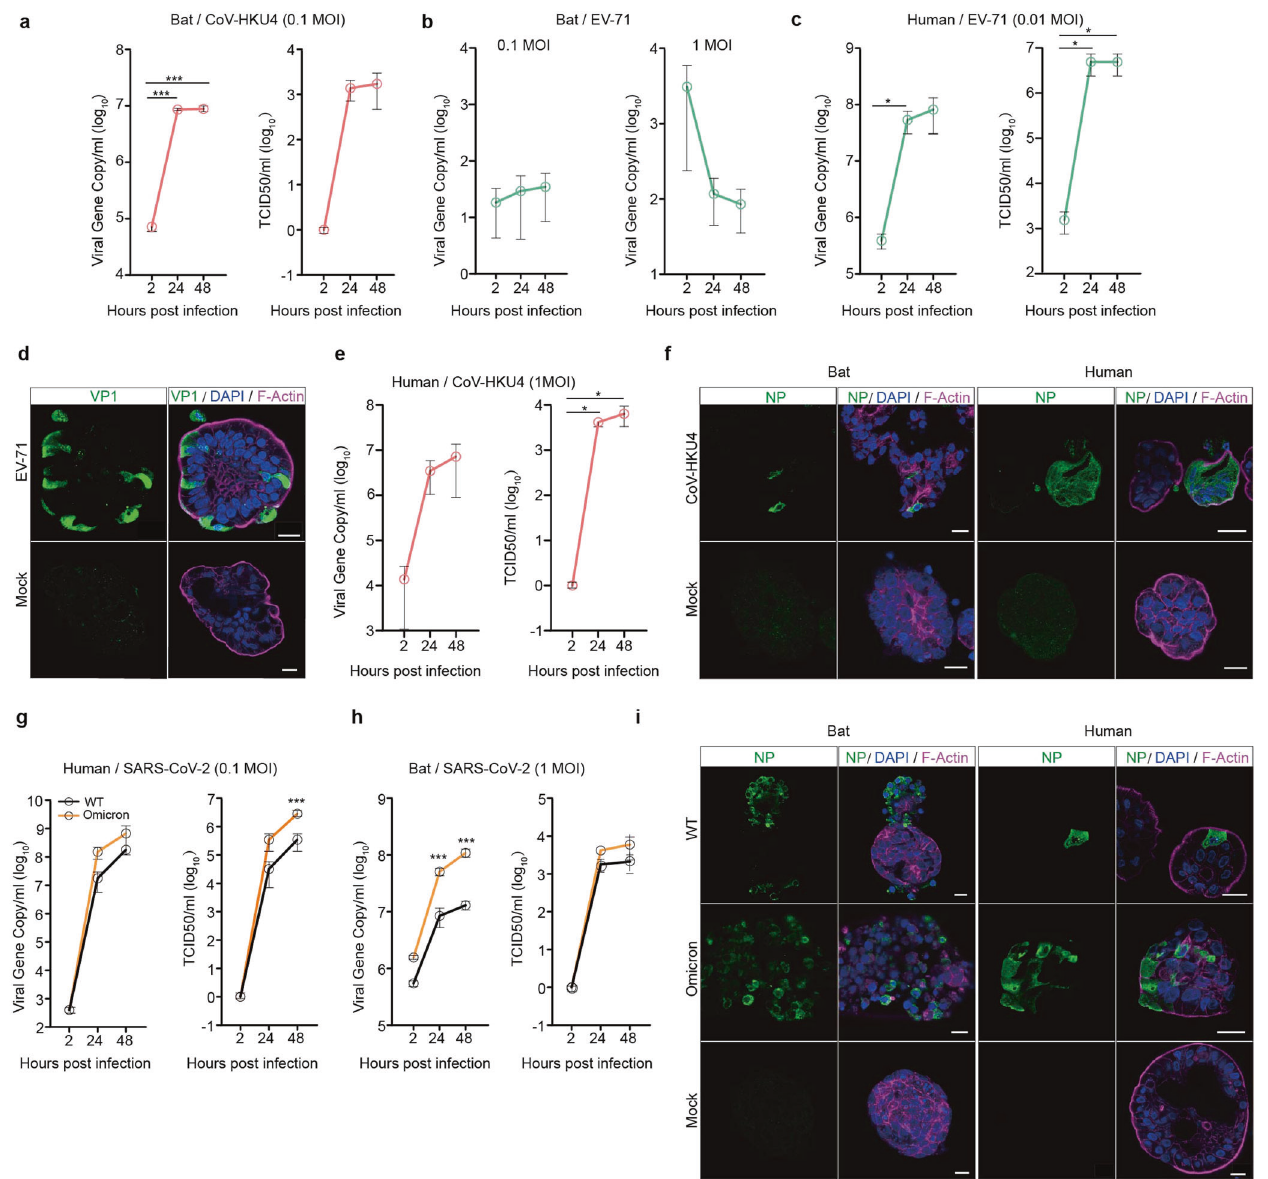
Fig. 4 Bat intestinal organoids reproduced bat susceptibility to coronaviruses. a – c At the indicated hours after bat intestinal organoids inoculated with CoV-HKU4 ( a ), EV-71 ( b ) and human intestinal organoids inoculated with EV-71 ( c ), culture media were harvested and applied viral protein VP1 positive (green) cells. Nuclei and actin fi laments were counterstained with DAPI (blue) and Phalloidin-647 (purple), respectively. Scale bar, 20 µm. e At the indicated hours after human intestinal organoids inoculated with CoV-HKU4, culture media were harvested and applied to viral load detection and viral titration. Data represent mean and s.d. in a representative experiment, n = 3. Two-tailed unpaired Student ’ s t test. f Bat and human intestinal organoids infected with CoV-HKU4 or mock-infected were fi xed and immunostained to identify CoV-HKU4 NP positive (green) cells. Scale bar, 20 µm. g , h At the indicated hours after human and bat intestinal organoids inoculated with WT SARS-CoV-2 and the Omicron variant, culture media were harvested and applied to viral load detection and viral titration. Data represent mean and s.d. in a representative experiment, n = 3. Ordinary one-way ANOVA with Tukey ’ s multiple comparison test. i SARS-CoV-2 infected and mock-infected bat and human intestinal organoids were fi xed and immunolabeled to identify SARS-CoV-2 NP positive (green) cells. Scale bar, 20